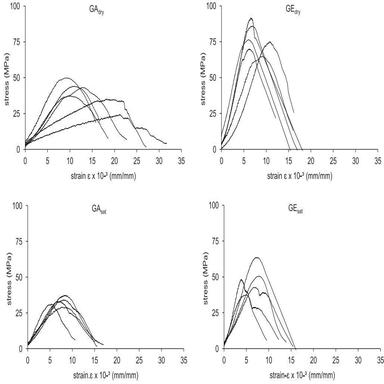
Stress–strain diagrams for GA and GE granites tested under dry (above) and saturated (bellow) conditions.